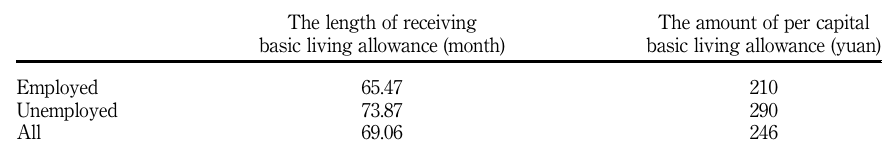
Table IV. Tied aid and employment and entrepreneurship services per capita among marginal families and families entitled to